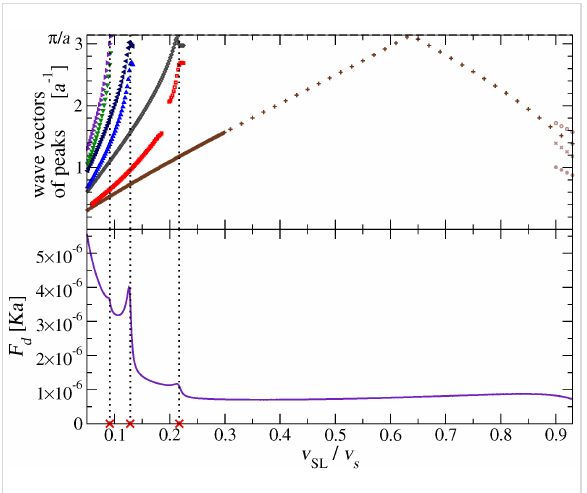
Figure 11: A direct comparison of the peak wave vectors of , with the dynamic friction F d as a function of v SL over the interesting speed range of Figure 6. The dotted vertical lines highlight the relation of the peaks of F d with the appearance of new pairs of excited phonons near the BZ boundary.